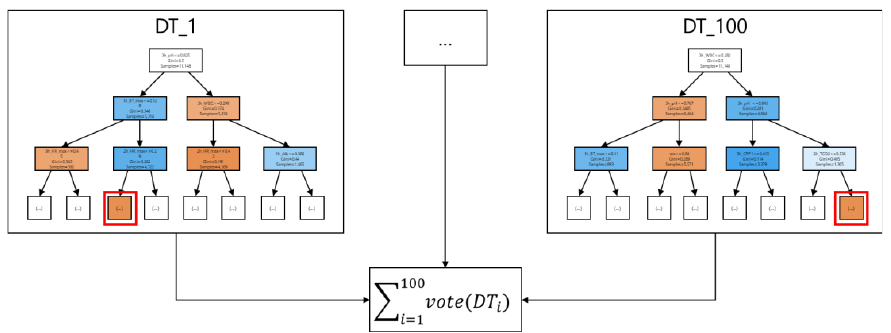
Figure 8. Decision tree. Orange indicates the prediction of respiratory failure in each node. Blue indicates non-respiratory failure. Darker nodes contain more data.